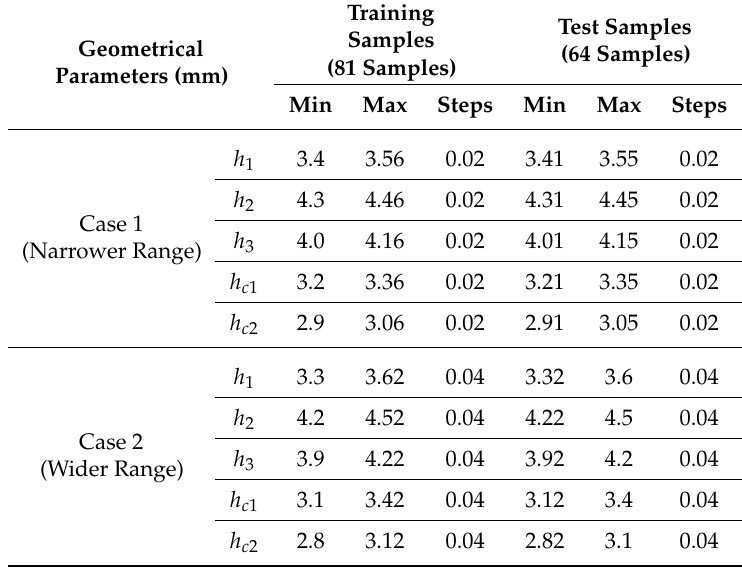
Table 4. Definition of training and test samples for the four-order bandpass filter